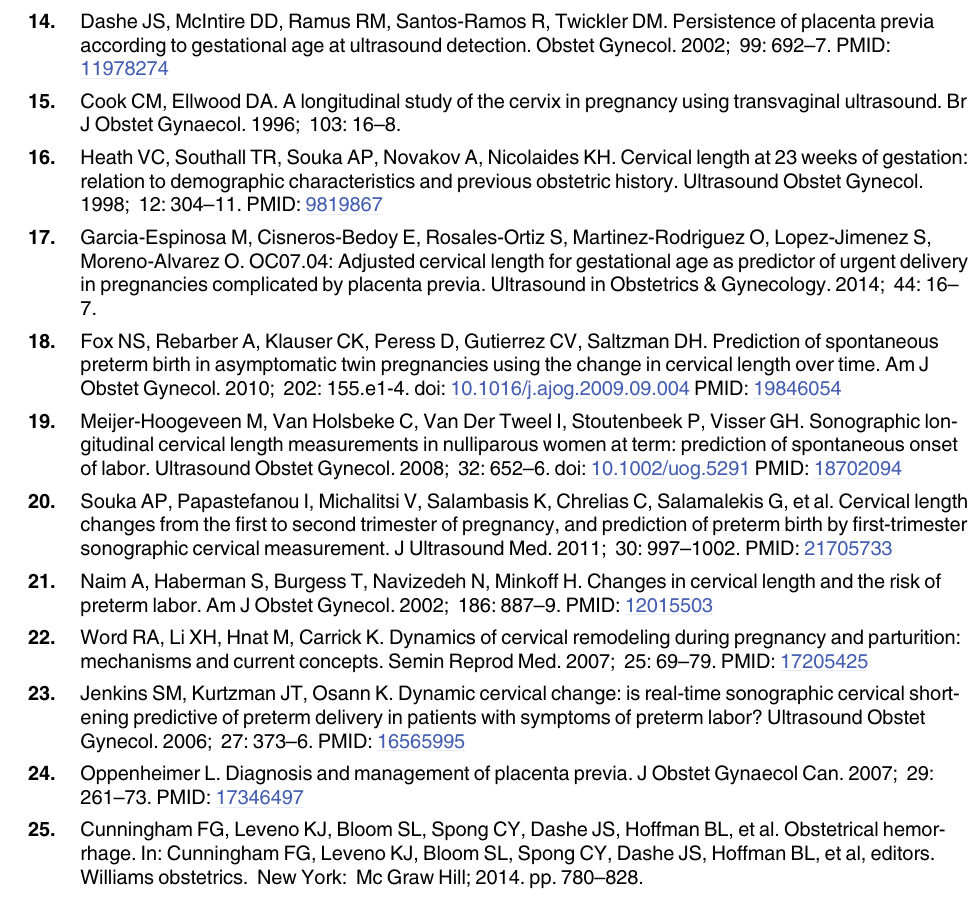
PLOS ONE | DOI:10.1371/journal.pone.0149036 February 10,